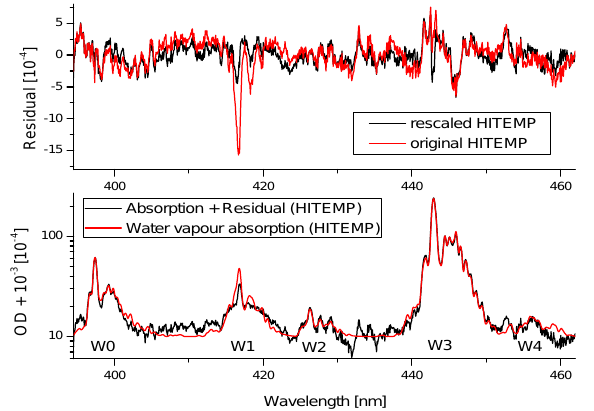
Figure 2. Fit residuals (top panel) and water vapour OD (bottom) for a MAX-DOAS observation using the HITEMP cross-section. A residual from an individual fit using the original HITEMP cross- section and a fit using separate column densities for each of the ab- sorption structures in the windows W0–W4 from HITEMP is shown in the top panel. From all fits with separate column densities for the absorption bands, correlation plots with respect to W3 were per- formed as shown exemplary in Fig. 3. The results are listed in Ta- ble 5. The overall water vapour column density calculated from the data shown above is dSCD = 5.31 × 10 23 moleccm − 2 .